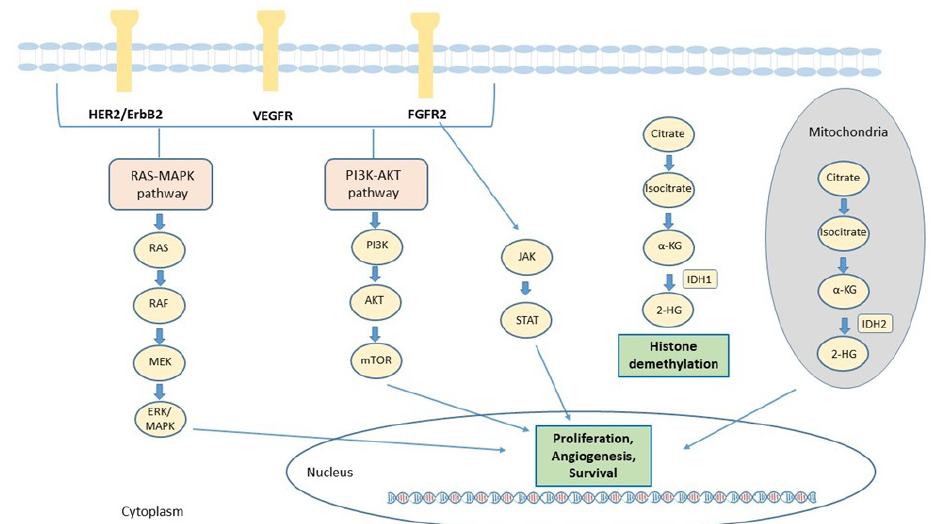
Figure 1. Main actionable signaling pathways in CCA. The signaling pathways involved in CCA progression and for which targeted agents are available, include receptor tyrosine kinases such as FGFR2 and ERBB and downstream signaling proteins, such as Janus kinases (JAK)/signal transducer and activator of transcription proteins (STAT), rat sarcoma virus (RAS)/ Raf-1 proto-oncogene, serine/threonine kinase (RAF)/mitogen-activated extracellular signal-regulated kinases (ERK) kinase (MEK)/(ERK) and phosphatidylinositol 3-Kinase (PI3K). In addition, mutant IDH enzymes acquire the capacity to synthesize 2-HG from α-ketoglutarate (α-KG). 2-HG alters the activity of α-KG–dependent dioxygenase enzymes involved in cell differentiation, survival, and DNA methylation. HER2: human epidermal growth factor receptor 2; VEGFR: vascular endothelial growth factor receptor; MAPK: mitogen-activated protein kinase; AKT: serine/threonine-protein kinase; mTOR: mammalian target of